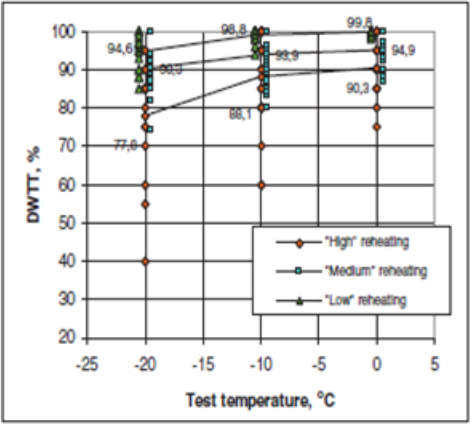
Figure 13. Shear area of drop-weight tear tests (DWTT) versus DWTT test temperature (reproduced from [22], with permission from The Minerals, Metals &Materials Society,